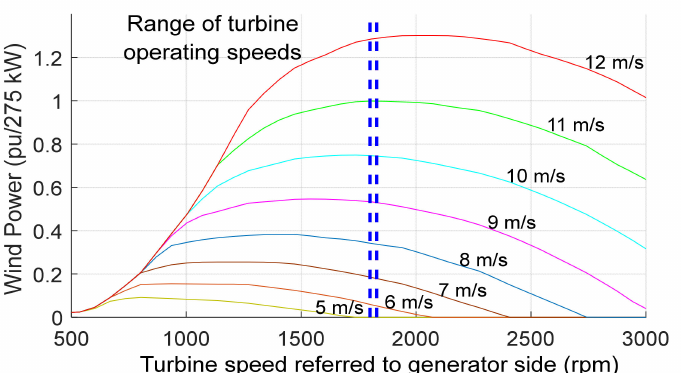
Figure 1. Operational characteristics of the wind turbine.